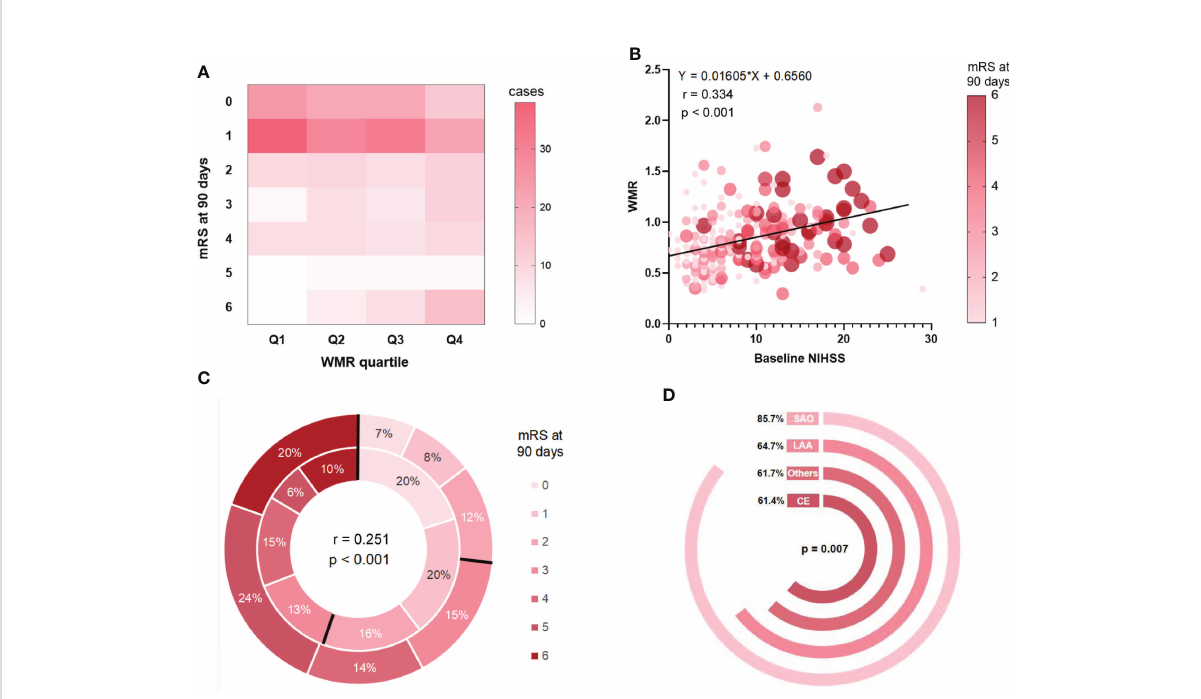
FIGURE 2 Correlation analyses between WMR and patient features and outcome. (A) : Case distribution across quartile-based categories of WMR and mRS score at 90 days. (B) : The relationships between WMR and baseline NIHSS as well as mRS at 3 months. (C) mRS distribution at 3 months for high WMR group v.s. low WMR group. The outer layer represented distribution of mRS score in high WMR group while the inner layer represented that in low WMR group. (D) : Ratio of low WMR group in different stroke